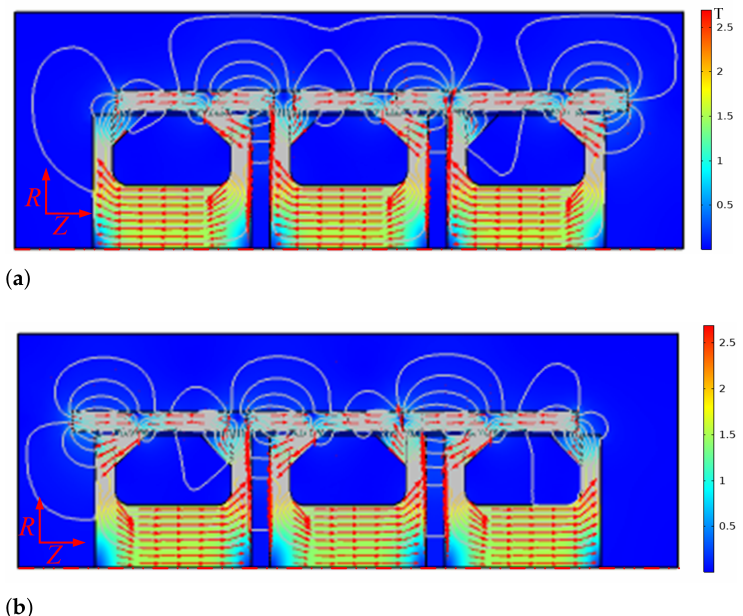
Figure 9. Flux lines and flux density distribution in proposed TMM-LOA: ( a ) positive extreme; and